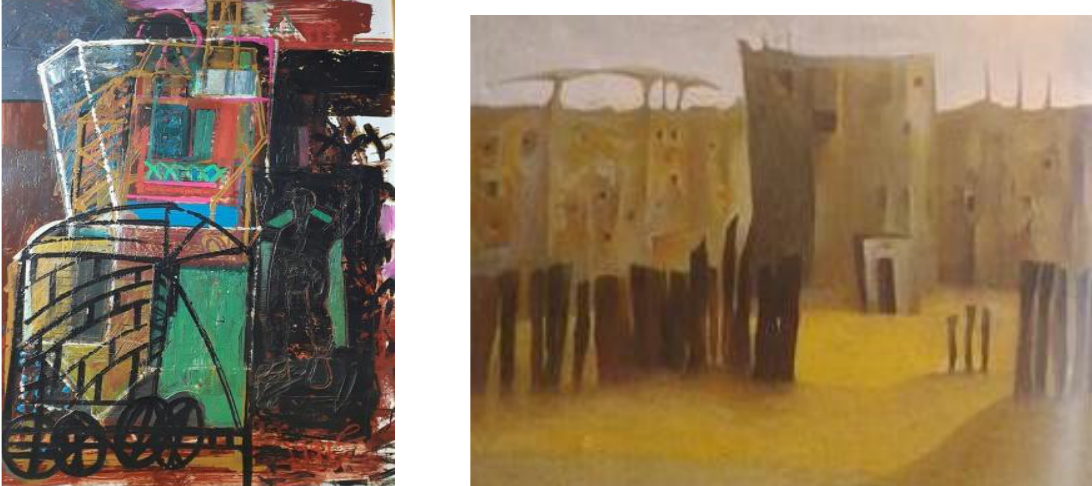
Fig. 26 The rhythm of life in the city 2 Oil painting on Cardboard 100x70 -1991